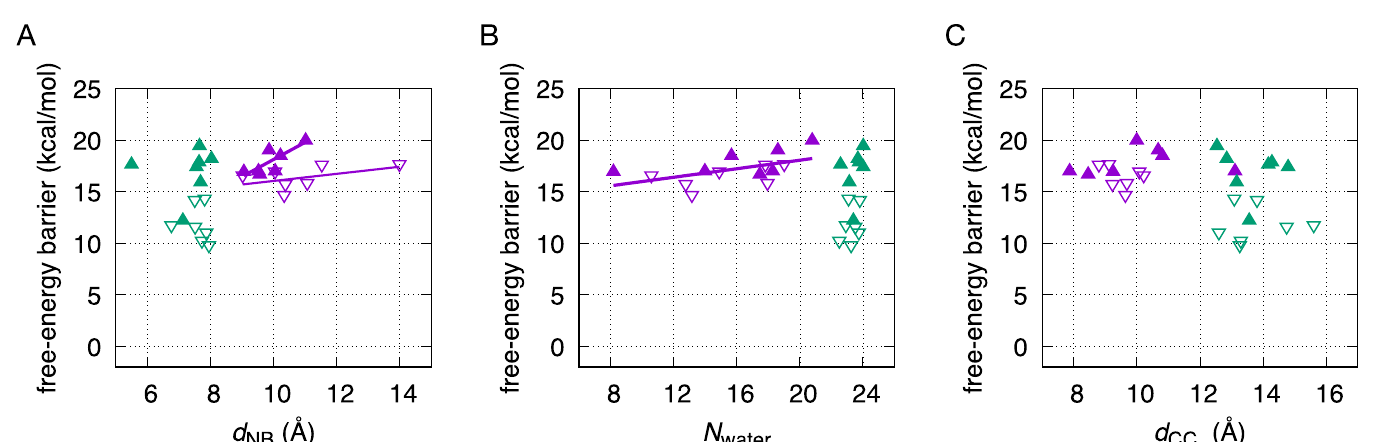
Fig 3. Trends between the WCF-to-HG free-energy barriers and the average value of a few selected CVs. The free-energy barriers are reported in Fig 2. The average values of the selected CVs are taken from the attractors restrained at s = − 0.5 and s = 0.5. Inside paths are shown in purple and outside paths are shown in green. The barriers for the rotation with the A16 6-ring pointing in the 5’ direction are represented in solid triangles pointing up, while the ones in the 3’ direction are represented in outlined triangles pointing down. (A) Free-energy barrier vs. the distance between the neighboring bases of A16, d NB . The fit of the inside 5’ direction barriers is shown with a thick purple line (free-energy barrier = 1.7 kcal/(mol Å ) d NB + 1.5 kcal/mol). The linear fit of the inside 3’ direction barriers is shown with a narrow purple line (free-energy barrier = 0.3 kcal/(mol Å ) d NB + 12.6 kcal/mol). (B) Free-energy barrier vs. the number of water oxygens within 6 Å of the N6 atom of A16, N water . The linear fit of the inside 5’ and 3’ direction barriers is shown with a thick purple line (free-energy barrier = 0.2 kcal/mol d NB + 13.9 kcal/mol). (C) Free-energy barrier vs. the distance between the C1’ atoms of A16 and T9, d CC .